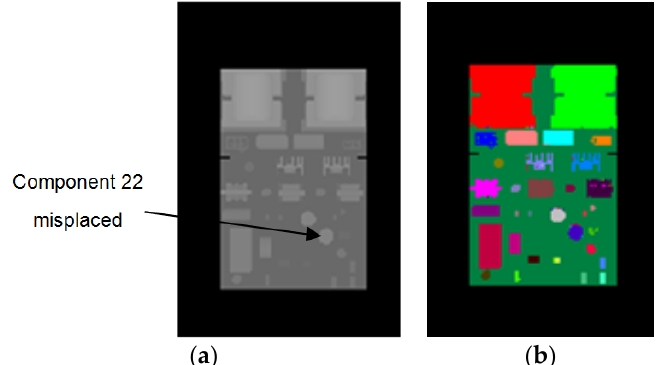
Figure 12. PCB with component 22 misplaced. ( a ) Synthetic depth image. ( b ) The resulting pixel classification image of ( a ).